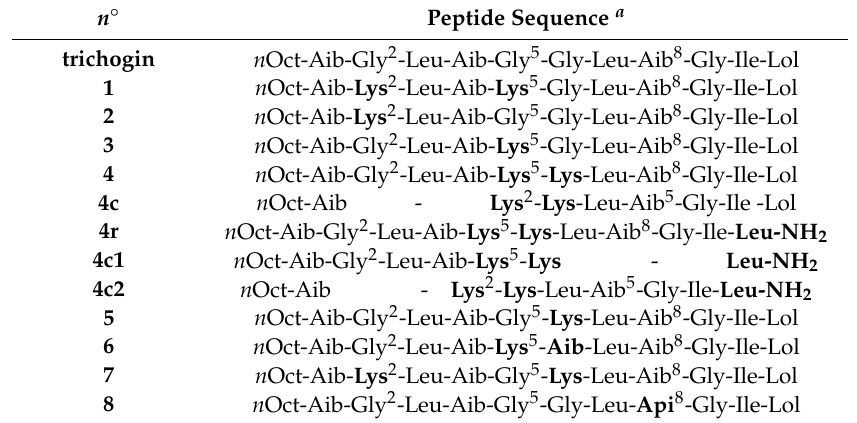
Table 1. Sequences of the synthesized trichogin analogs. Modified residues are highlighted in bold.